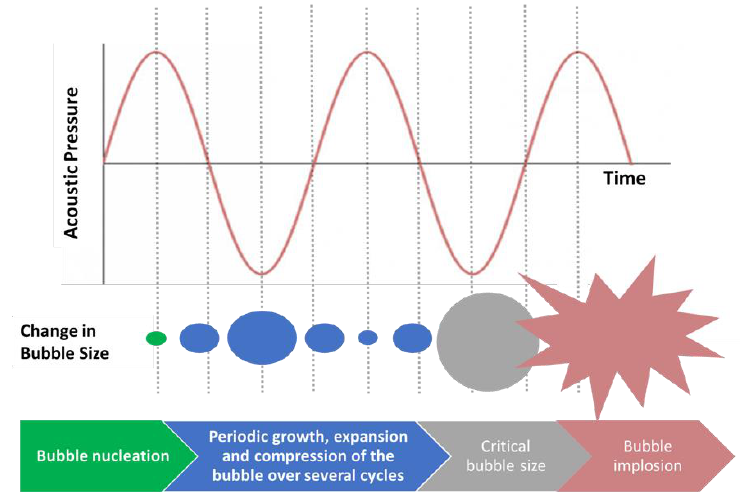
Figure 4. Rectified diffusion mechanism under the effect of sinusoidal acoustic streaming.